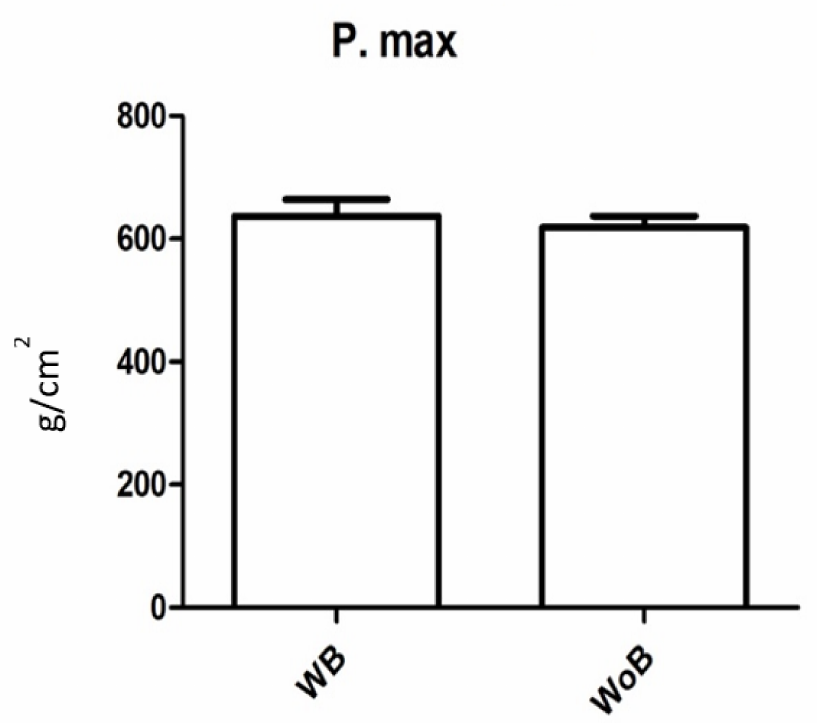
Figure 1. Evaluation of the point of maximum pressure (g/cm 2 ) in static measurements with (WB) and without (WoB) brace. Error bars represent Standard Error (SE).